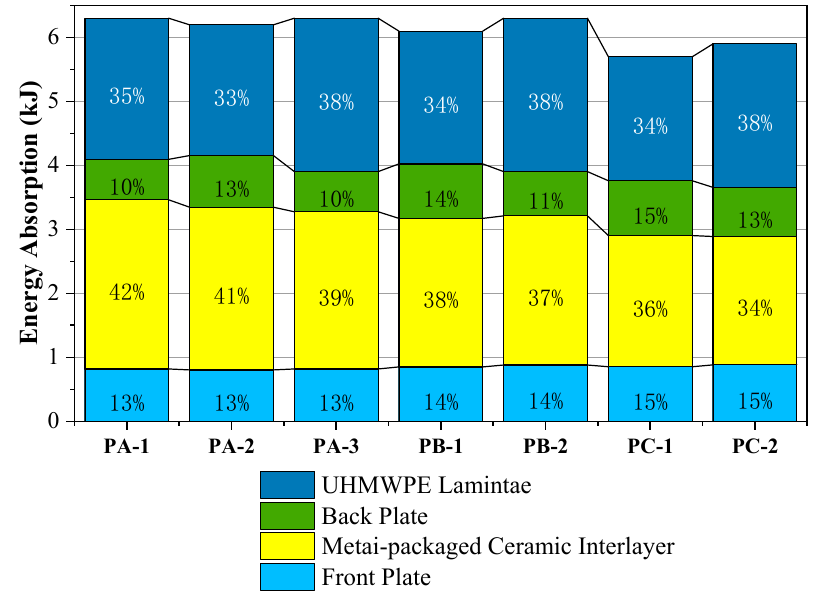
Figure 22. Breakdown of energy absorption within the composite structure at varying impact posi- tions.